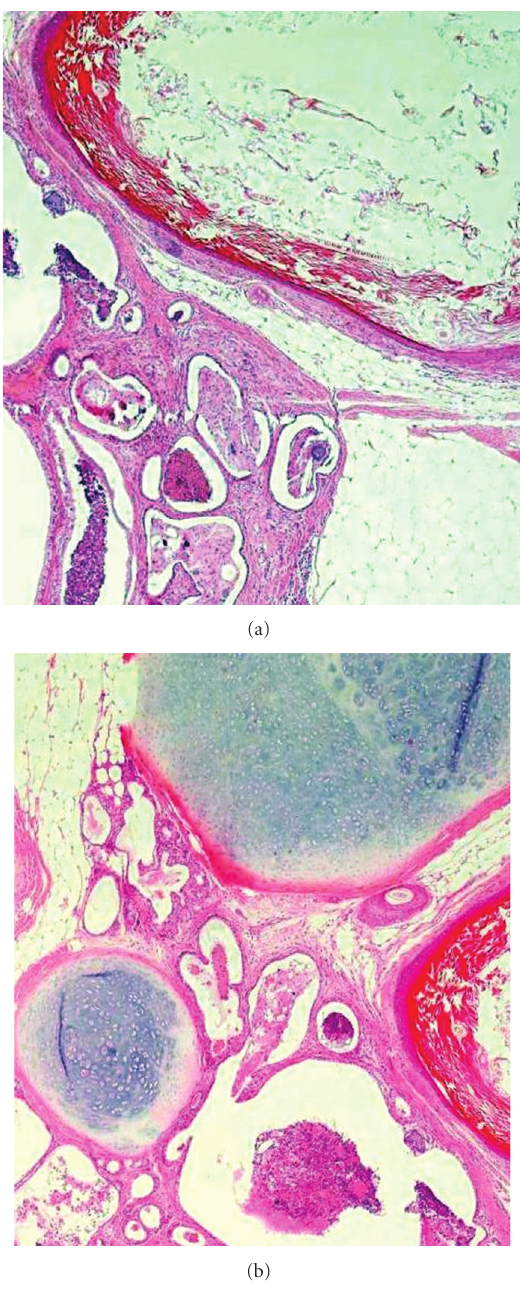
Figure 3: Photomicrographs of specimen of lung showing benign mature teratoma, containing stratified squamous and respiratory epithelium, mature adipose tissue, cartilage, and connective tissue.